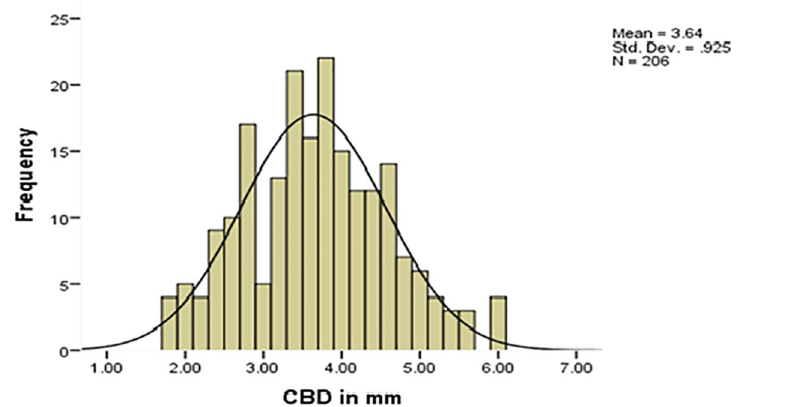
Fig 3. Histogram showing the frequency distribution of common bile duct diameter.